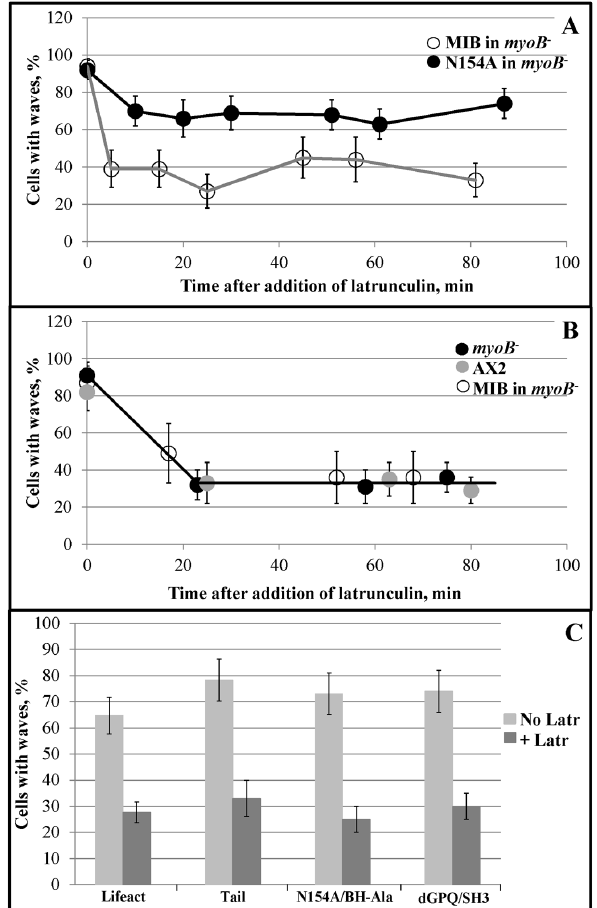
Figure 12. Mutation N154A increases the resistance of actin waves to latrunculin. Cells expressing mRFP-lifeact only or co- expressing mRFP-lifeact and either GFP-MIB or GFP-tagged MIB mutants were starved for 1 h at which time 4.2 m M latrunculin was added. Cells were scored for the presence of actin waves by mRFP-lifeact fluorescence as in Fig. 3. Short movies (10 frames every 10 s) of the fields of cells were taken before and after adding latrunculin and the percent of cells with waves was calculated. (A) myoB 2 -cells co- expressing lifeact and MIB (open circles) or lifeact and N154A (black circles). Time=0 corresponds to cells before addition of latrunculin. (B) myoB 2 -cells expressing lifact alone (black circles), parent AX2 cells expressing lifeact alone (grey circles) and myoB 2 -cells co-expressing lifeact and MIB (open circles). Time=0 corresponds to cells before addition of latrunculin. (C) myoB 2 -cells expressing lifeact only or co- expressing lifeact and either Tail, N154A-BH-Ala or dGPQSH3 in the absence (grey bars) and presence (black bars) of latrunculin. Movies were recorded before addition of latrunculin (No Latr) and between 60 and 80 min after addition of latrunculin ( + Latr) at which time the percentage of cells with waves plateaus. The results are representative of at least 2 independent experiments. Error bars were calculated using the binomial probability confidence interval calculator developed by Daniel S. Soper (http://www.danielsoper.com/statcalc) and correspond to the 95% confidence interval.